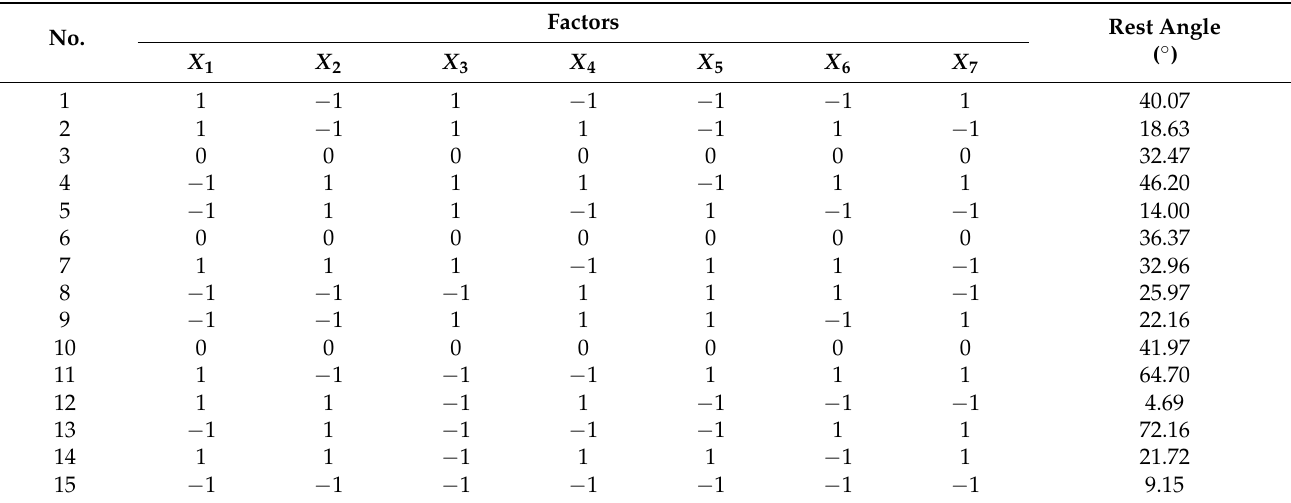
Table 6. Plackett–Burman experimental design and